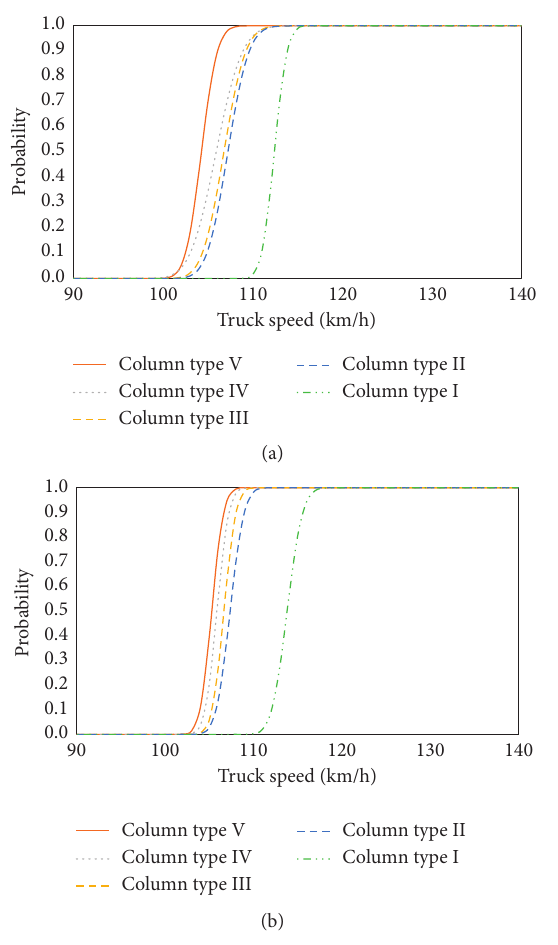
Figure 16: Fragility curve of 38-ton truck-bridge column collision for response moderate (RM). (a) Concrete compressive